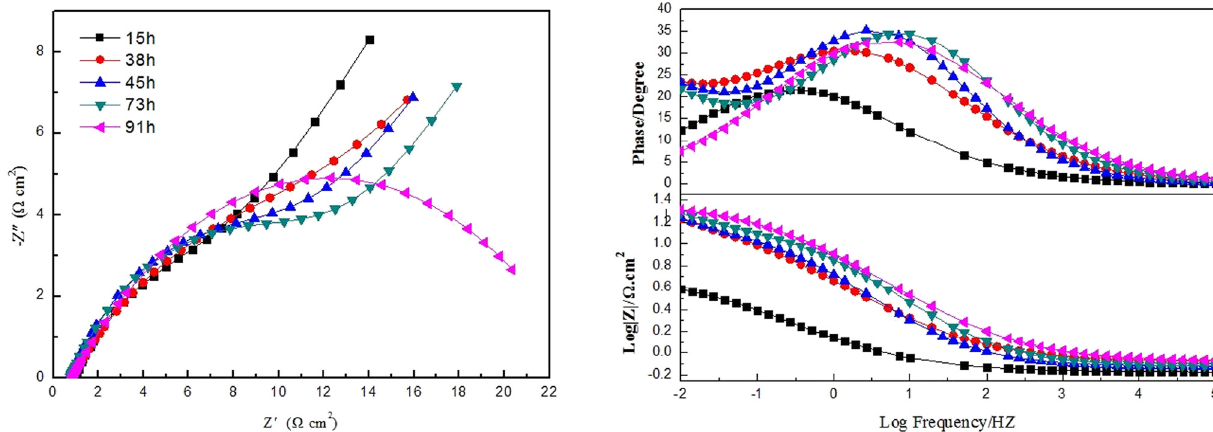
Figure 8: Impedance Nyquist plots and bode diagrams of 316 ss in ternary chloride molten salt at